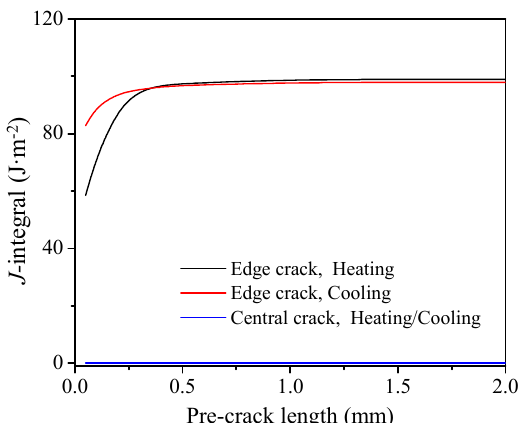
Figure 6. J i of edge crack and central cracks after rapid heating and cooling of the pure epoxy coating system.